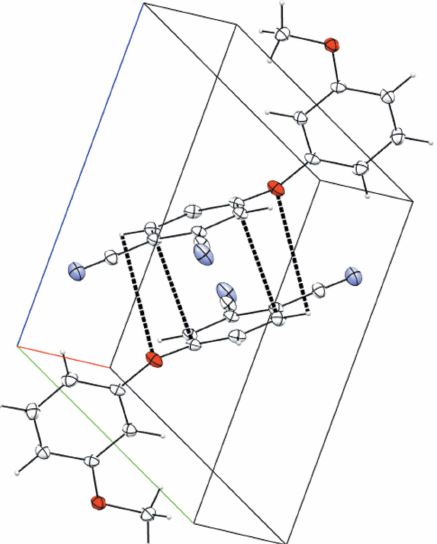
Figure 4 The molecular structure of m -4-(3-methoxy phenoxy)phthalonitrile dimer, linked by (cid:2) – (cid:2) -interactions and supporting weak H (cid:4)(cid:4)(cid:4) O contacts. Displacement ellipsoids are drawn at the 50% probability level.